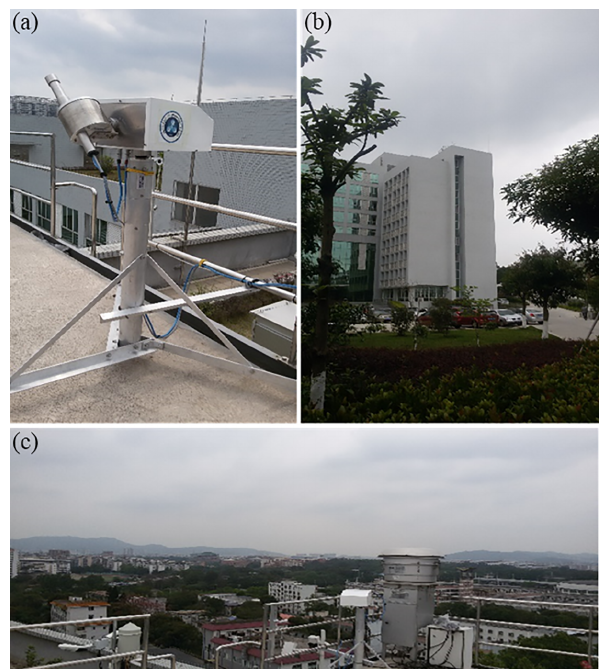
Figure 1. The tracker and entrance optics of the Phaethon MAX- DOAS system (a) installed on the roof of the Institute of Geo- chemistry, Chinese Academy of Sciences, in Guangzhou (b) and an overview of the surrounding area towards west (c)